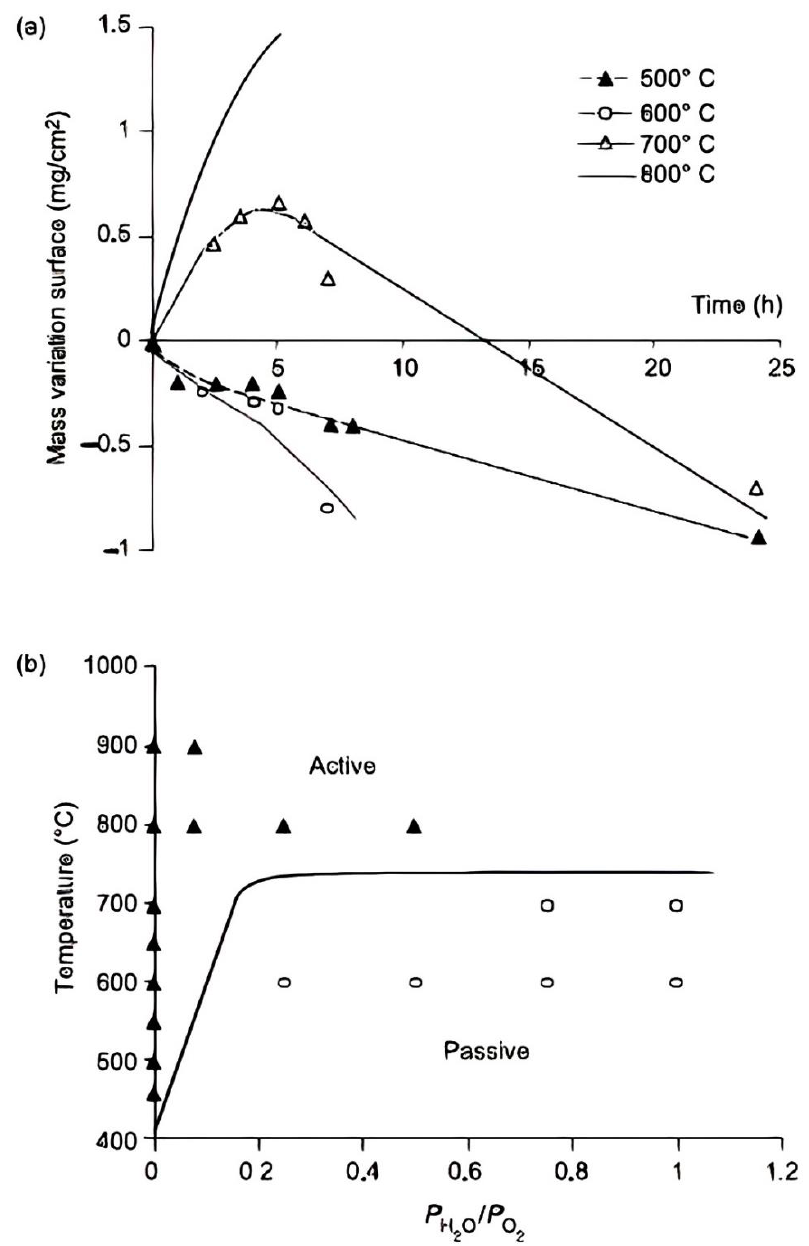
Figure 14. ( a ) Effect of temperature on B 4 C oxidation. ( b ) Changes due to the composition of the gaseous phase [158].